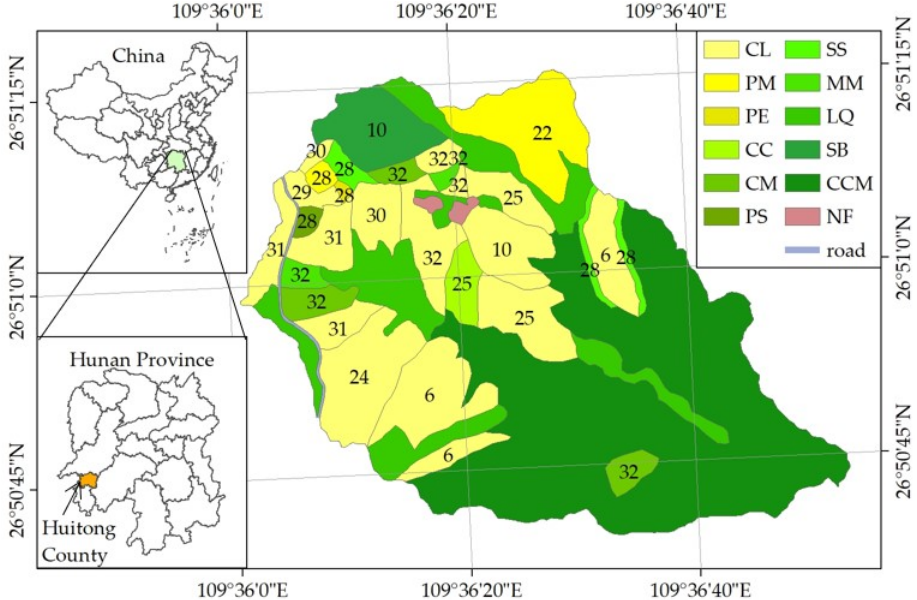
Figure 1. Forest vegetation map of the Moshao forest farm. The numbers on the map indicate the age of the plantations, LQ and CCM are natural forests with no specific age number. NF = non-forest. The study area has 11 tree species: C. lanceolata (CL), P. massoniana (PM), Pinus elliottii , mixed C. lanceolata and Cinnamomum camphora (CC), mixed C. lanceolata and Michelia mac- clurei (CM), mixed P. massoniana and Schima superba (PS), S. superba (SS), M. macclurei (MM), mixed Liquidambar formosana and Quercus fabri (LQ), mixed S. superba and